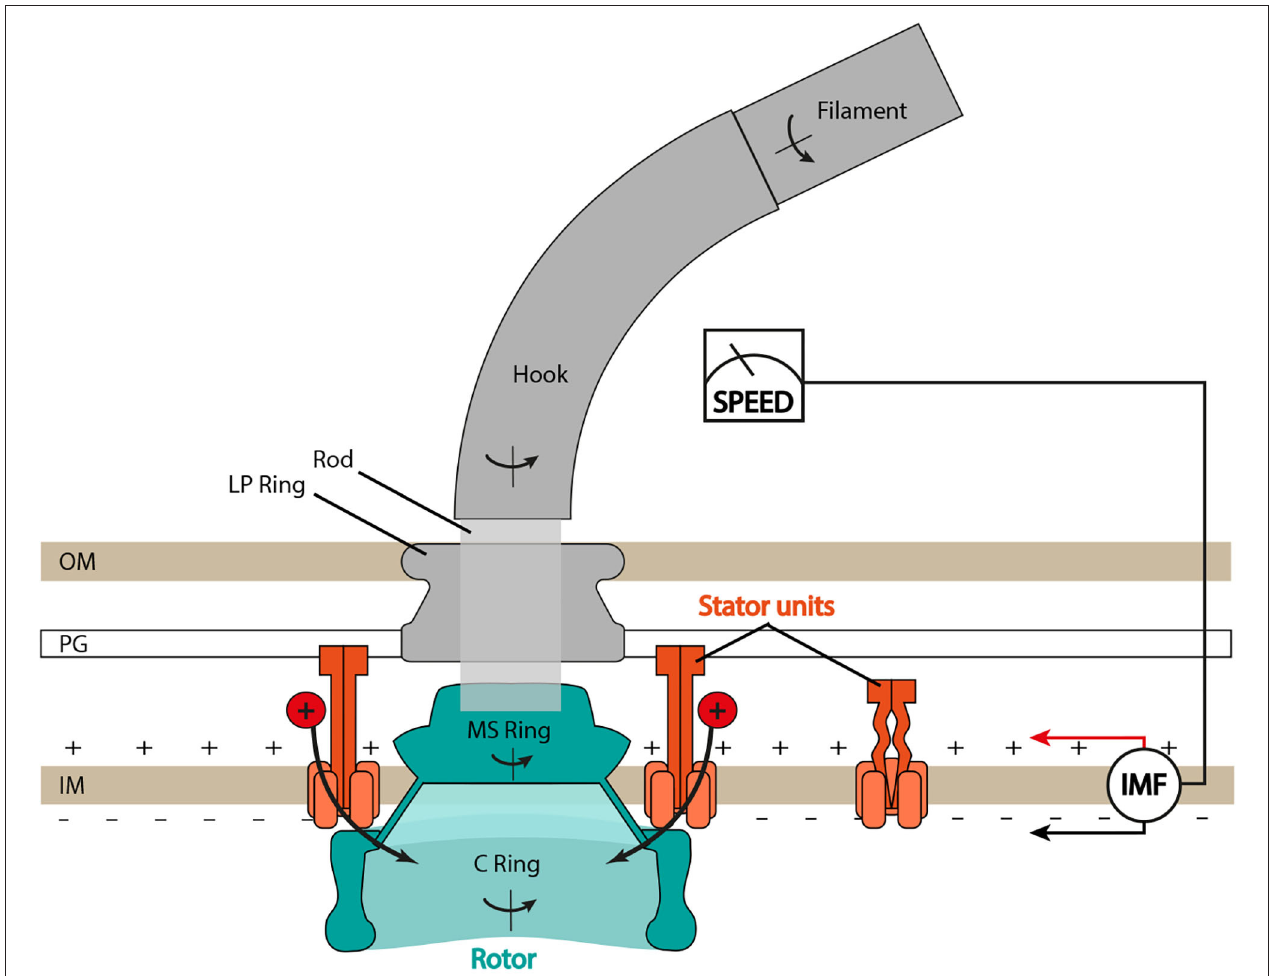
FIGURE 1 | Schematic of the bacterial flagellar motor (BFM) in Gram-negative bacteria. The flagellar filament is connected to the rotor (in blue) through the hook, the universal joint, and the rod, the central driveshaft that connects the hook to the MS ring. The LP ring is assembled around the rod and acts as a bushing. Stator units bind to the peptidoglycan (PG) layer, translocate ions from the periplasm to the cytoplasm, and generate torque by interacting with the C ring. IM, inner membrane; OM, outer membrane. Type III export apparatus not